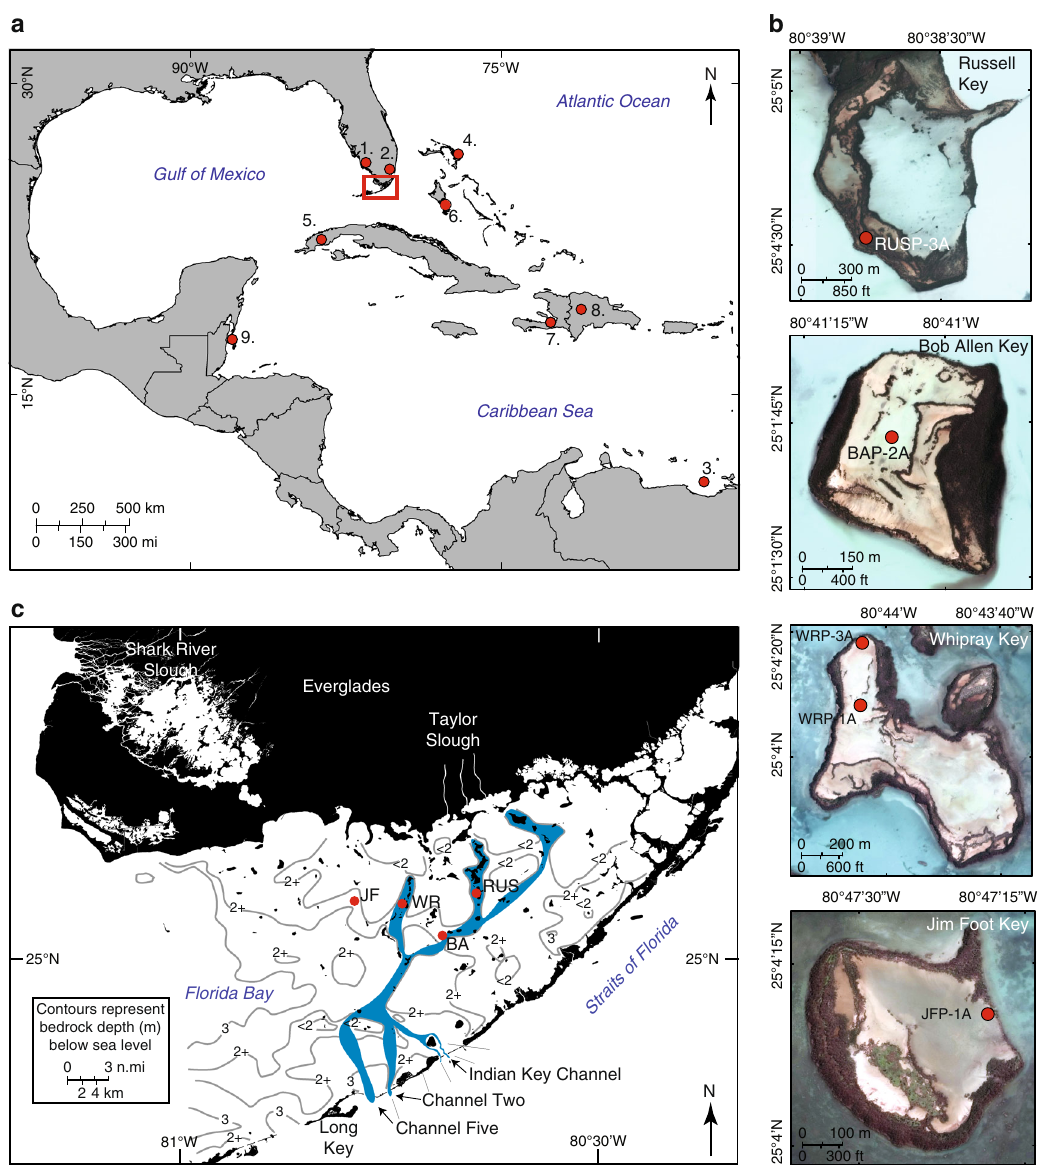
Fig. 1 Study area map. a Regional map showing the study location (red square) and other sites discussed: (1) Faxahatchee Strand 37 , (2) Northeast Shark River Slough 38 , (3) Cariaco Basin 42 , (4) No Man ’ s Land, Bahamas 46 , (5) Dos Anas Cave, Cuba 47 , (6) Church ’ s Bluehole, Andros 48 , (7) Lake Miragoane, Haiti 40 , (8) Valle de Bao, Dominican Republic 50 , (9) Turneffe Atoll, Belize 51 . b Aerial photographs show core locations on each island; use of a Russian peat corer eliminated sediment compaction and allowed determination of accurate paleo-elevations of peat deposits. c Detail of Florida Bay: locations of the four mud islands studied in Florida Bay, showing bedrock topography and indicating the proposed paleo-drainage channels of Taylor Slough 83 . Rhizophora (red) and Avicennia (black) mangroves ring the islands, creating a buffer for the fresh to hypersaline carbonate mud fl ats in the island centers, which were situated below sea level when cores were taken in 2014. Satellite images collected by DigitalGlobe ’ s WorldView-3 sensor on September 13,